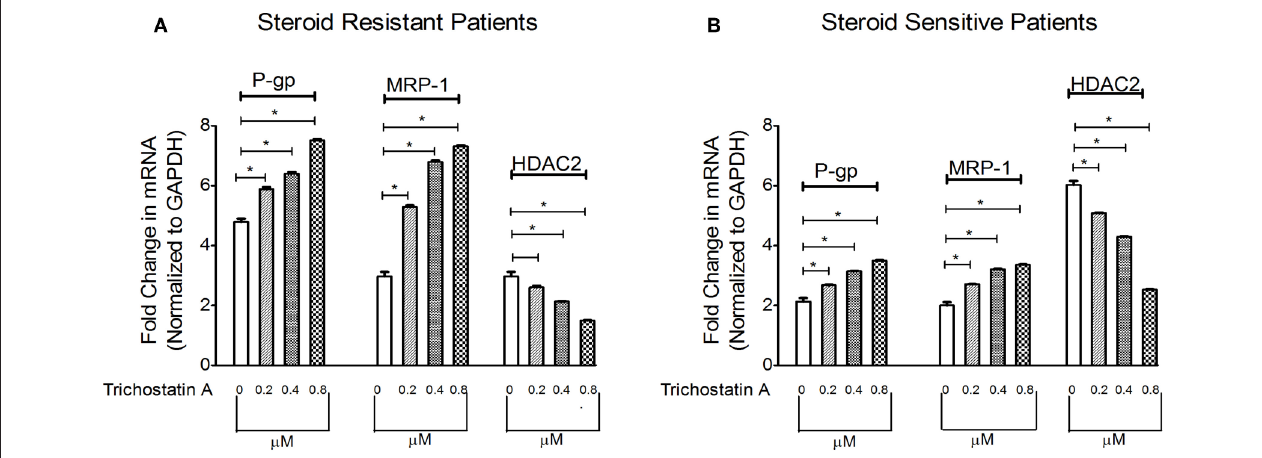
FIGURE 3 | Effect of HDAC2 inhibitor Trichostatin A expression levels of P-gp, MRP-1 and HDAC2 in SRNS and SSNS patients (A,B) . Quantitative real-time PCR of P-gp, MRP-1, and HDAC2 in peripheral blood mononuclear cells of SRNS and SSNS patients treated with different concentrations of Trichostatin A (0, 0.2, 0.4, 0.8 µ M) for 48h. The experiments are representative of three independent series. Pooled data of all the experiments are represented as mean ± SEM. Significant differences compared to control were indicated by * p < 0.05.